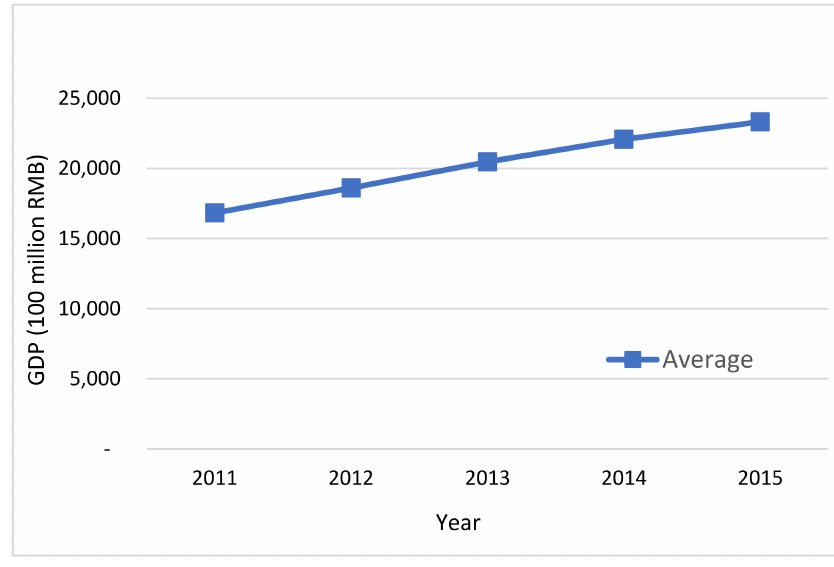
Figure 4. Average GDP over 2011–2015 in